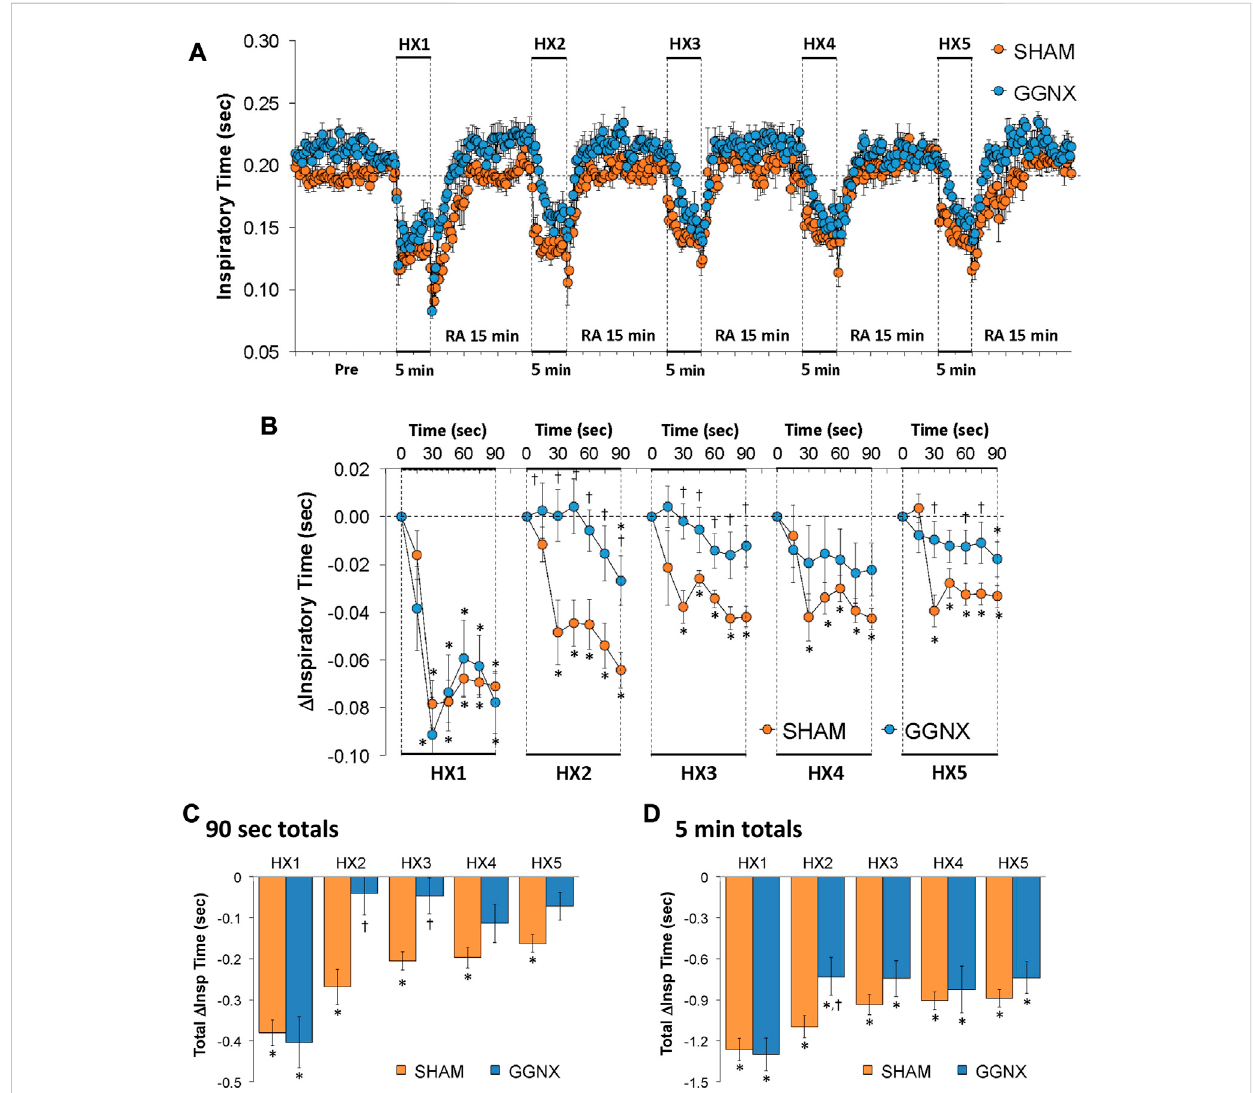
FIGURE 6 (A) Inspiratory time in sham-operated (SHAM) rats and in rats with bilateral ganglioglomerular nerve transection (GGNX) before (Pre) and during fi ve